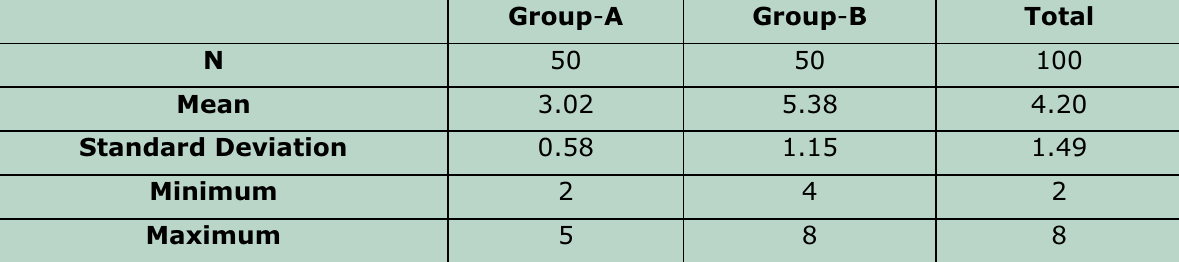
Table-III: Descriptive statistics for hospital stay (days) in treatment group.